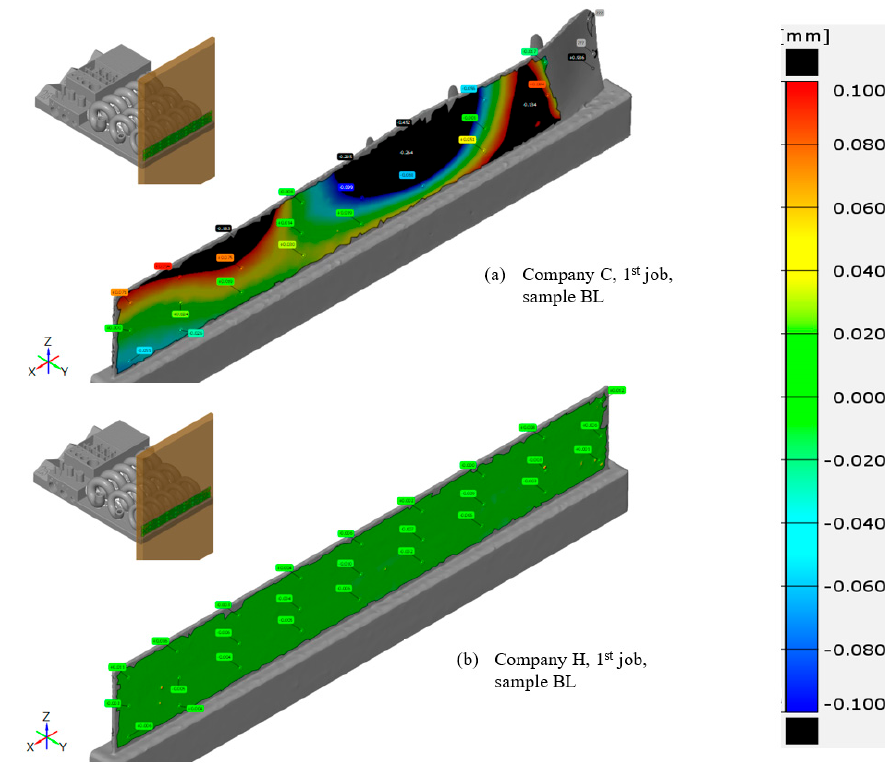
Figure 15. Comparison of the thin wall color plots from companies C and H. ( a ) sample BL from company C, 1 st job, ( b ) sample BL from company H, 1 st job.